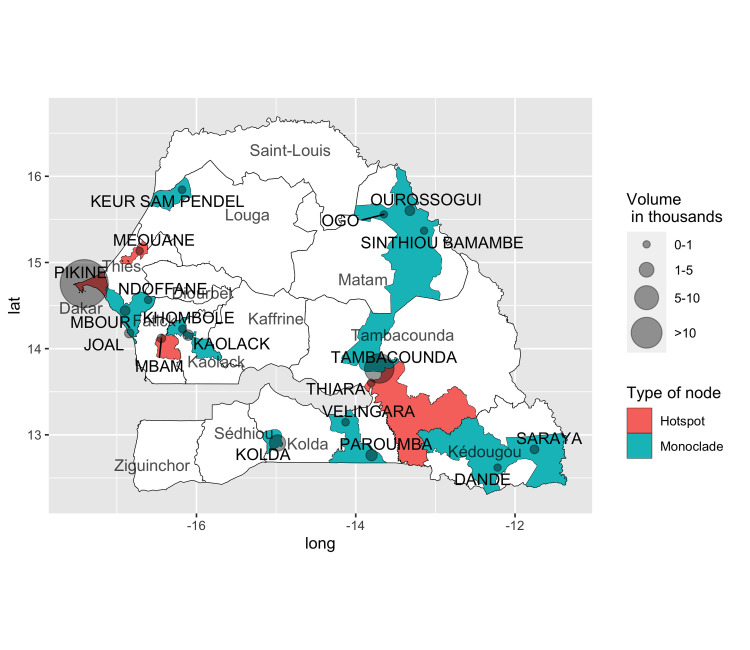
Geographical locations of hotspots and monoclade.Hotspots and monoclade are geolocalised and the wards (Administrative Unit of level 3) to which they belong are colored according to the type of node (hotspot or monoclade). Nodes are scaled based on their incoming volume of animals. Labels in uppercase letters indicate node names. Labels in lowercase letters correspond to the names of regions in Senegal. The base layer for the map used in the figure was obtained at http://www.gadm.org.